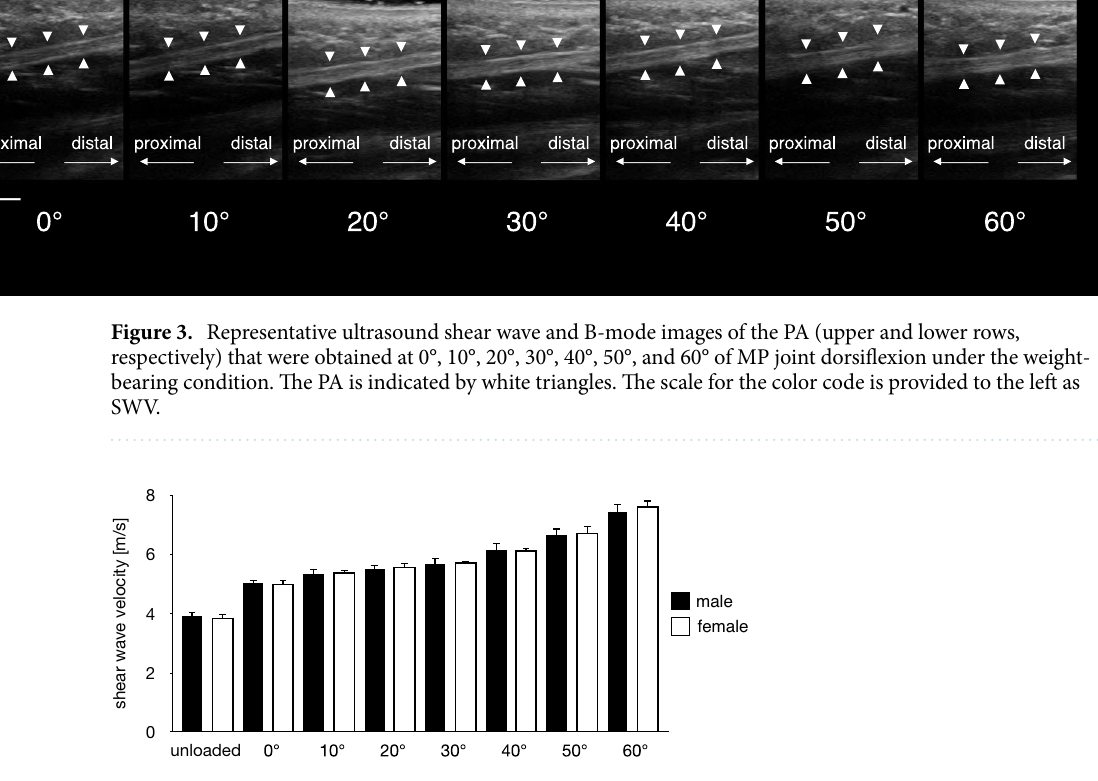
Figure 4. Gender-based comparisons of the SWV of the PA under all conditions. The error bars indicate standard deviations. There were no significant gender-associated differences in the SWV of the PA under all